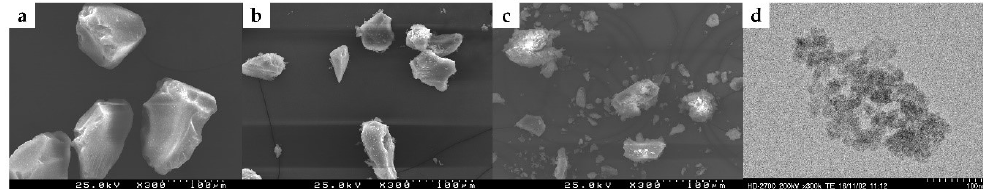
Figure 1. SEM images of free silica Si ( a ), SiPn ( b ) and SiTF 5 PP ( c ) and scanning transmission electron microscopy (STEM) image of SiTF 5 PP ( d ).